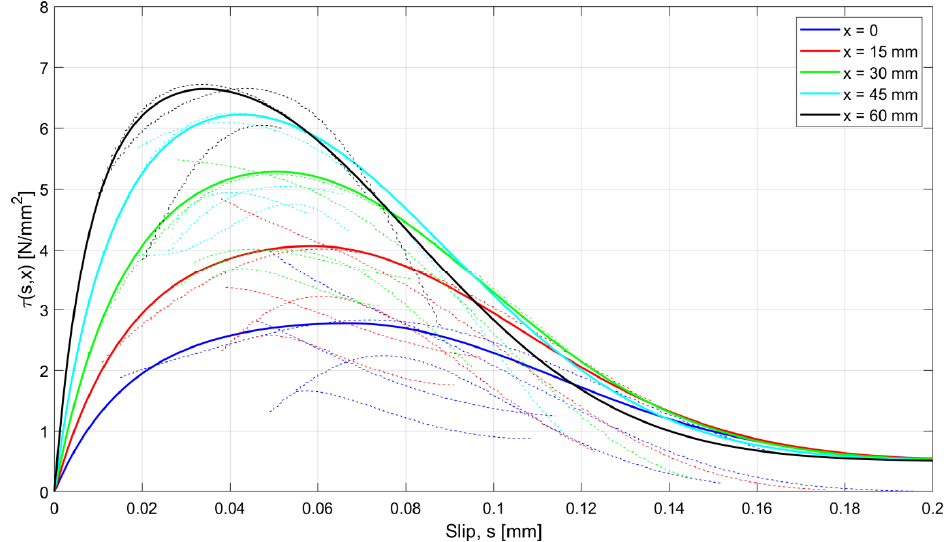
Figure 20. Comparison of the experimental bond–slip τ − s diagram, dashed lines; the proposed model for different abscissas x of the elements, solid lines.